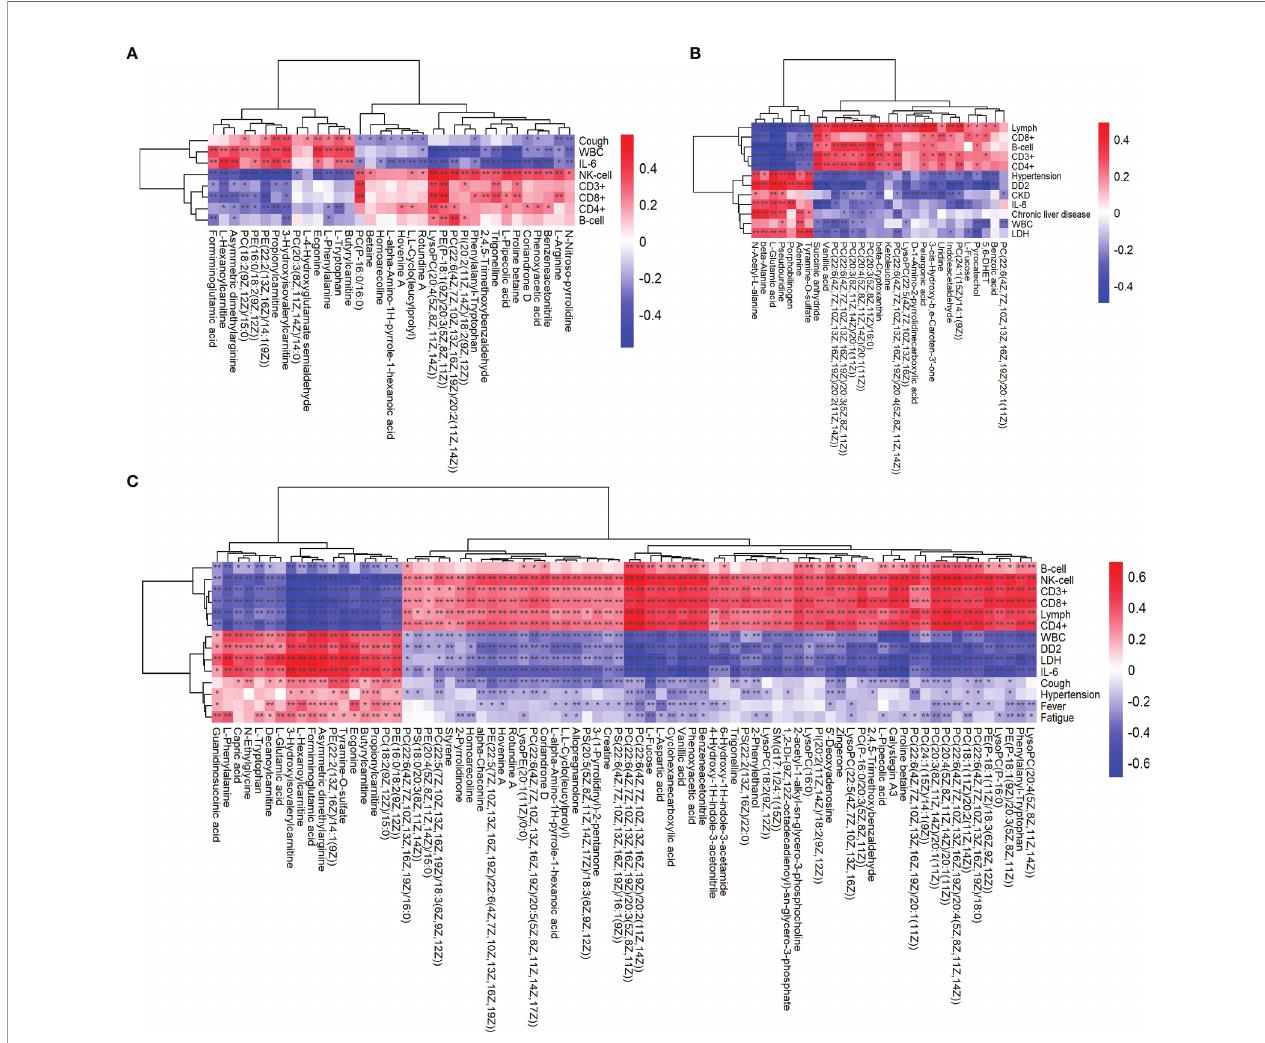
FIGURE 6 | Association analysis of clinical data with metabolomics analysis. Heat plot of the hierarchical clustering of differential metabolites between (A) the critical group and severe group, (B) severe group and ordinary group, and (C) critical group and ordinary group. p -value is plotted in a color map. Data were analyzed by unpaired two-sided Welch's t test. *p < 0.05; **p <